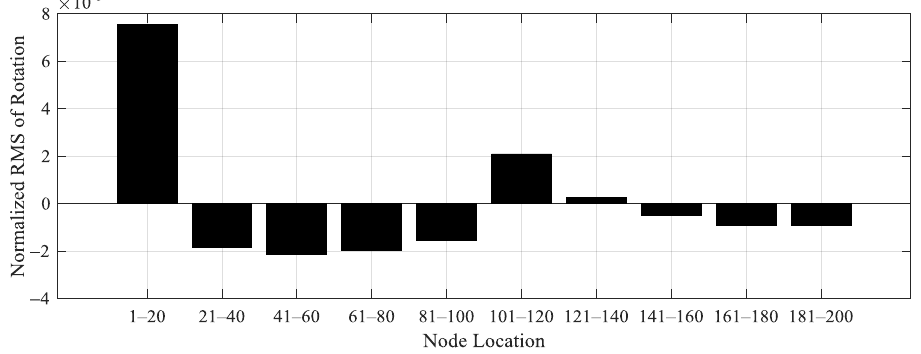
Figure 25. Level 2 damage indicator for Case 6.